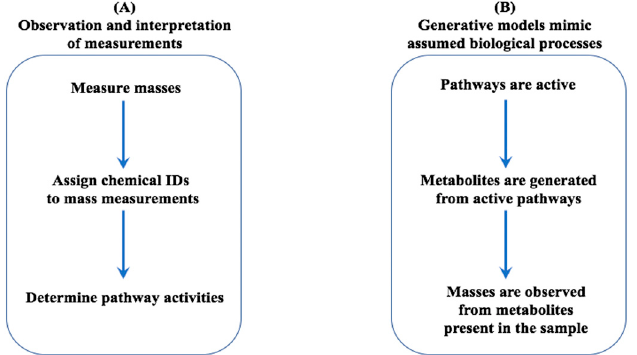
Figure 2. Comparison of a workflow to collect and interpret observations ( A ), and a generative model that captures a biological process ( B